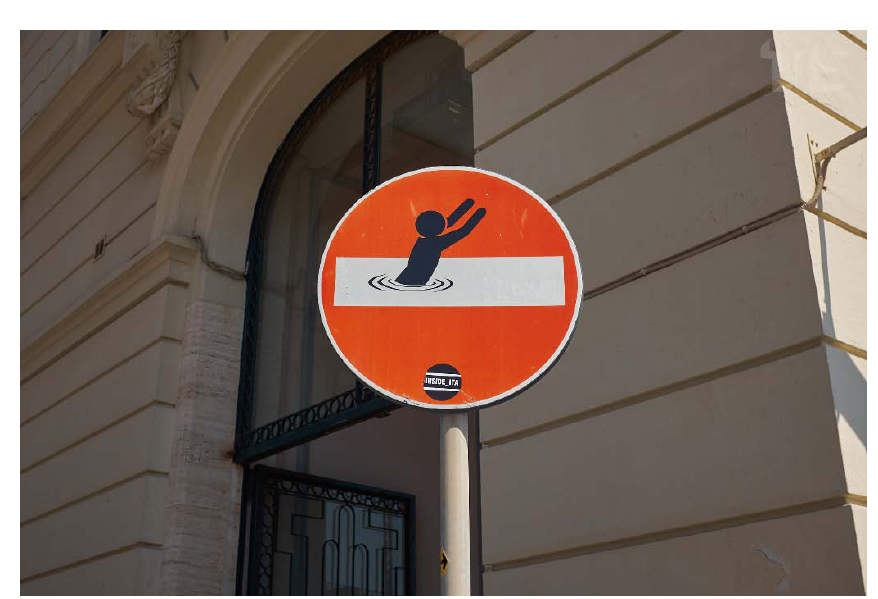
Figure 9. Unknown Artist. Paris,